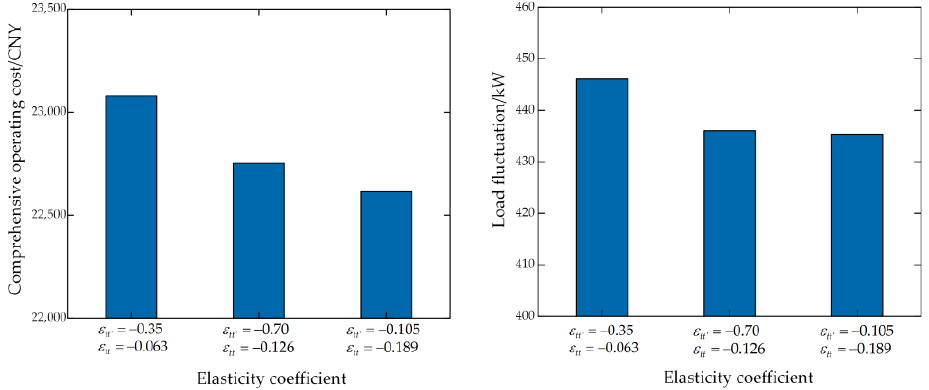
Figure 12. Influence of different elastic coefficients on operating results.